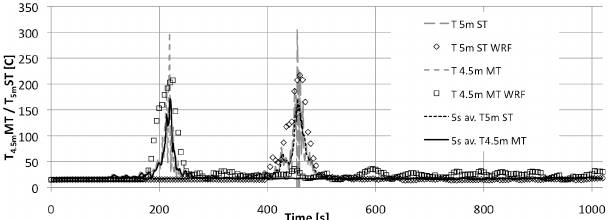
Fig. 4. Time series of the 4.5ma.g.l. air temperature at the location of the main tower (MT) and 5ma.g.l. air temperature at the short tower (ST). Gray lines show 1Hz measurements, black lines 5s av- eraged values, and symbols (diamond and square) model data.